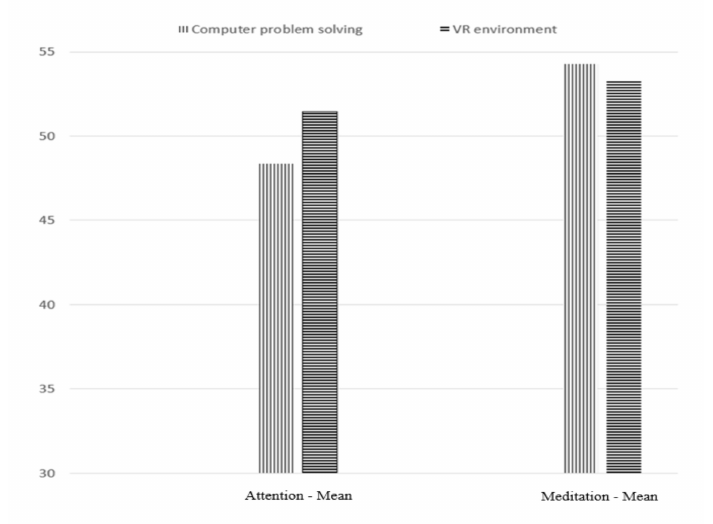
Figure 7. Measurements of attention and meditation mean values.